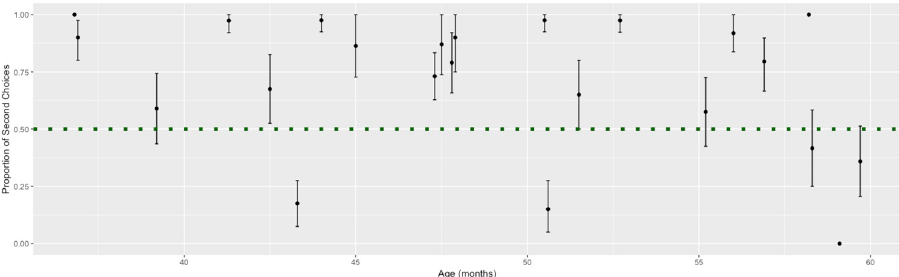
Fig 5. Recency bias present in preschoolers. Each dot represents an individual’s proportion of second choices. The error bars depict 95% confidence intervals. The dotted line represents chance. Fourteen participants exhibited significantly more second-choice responses than chance would predict. Three participants exhibited significantly less second-choice responses than chance would